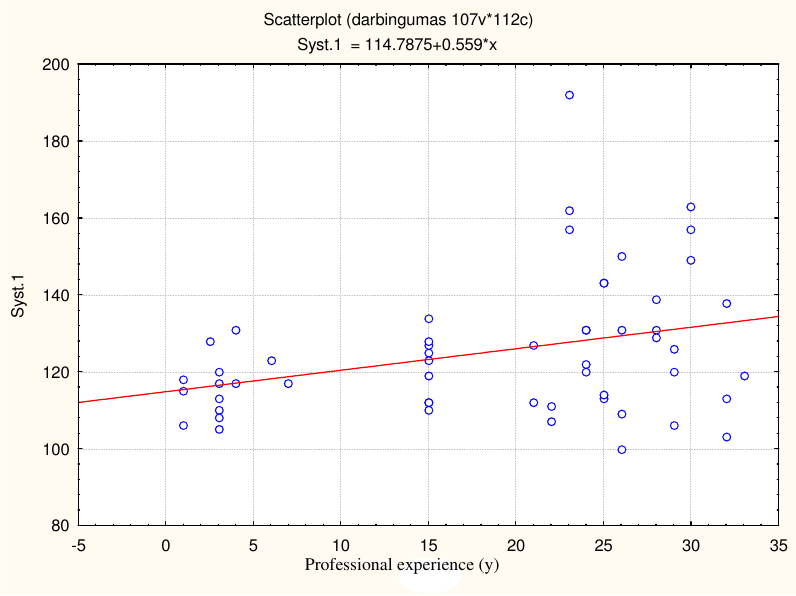
Fig 3. Professional experience (y) and arterial systolic blood pressure